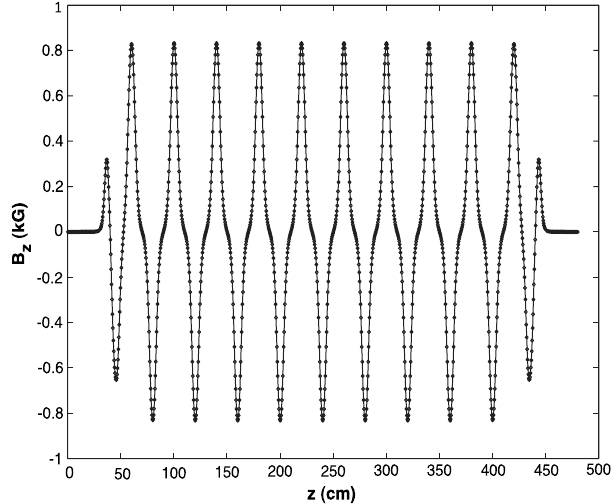
FIG. 23. Fit to the proposed ILC wiggler longitudinal field versus z , where x ¼ 0 : 4 cm , y ¼ 0 : 2 cm . The solid line is computed using data on the surface of an elliptical cylinder with x max ¼ 4 : 4 cm , y max ¼ 2 : 4 cm , using the polynomial series for B obtained from (11) or (12). Dots represent numerical data provided by OPERA-3D